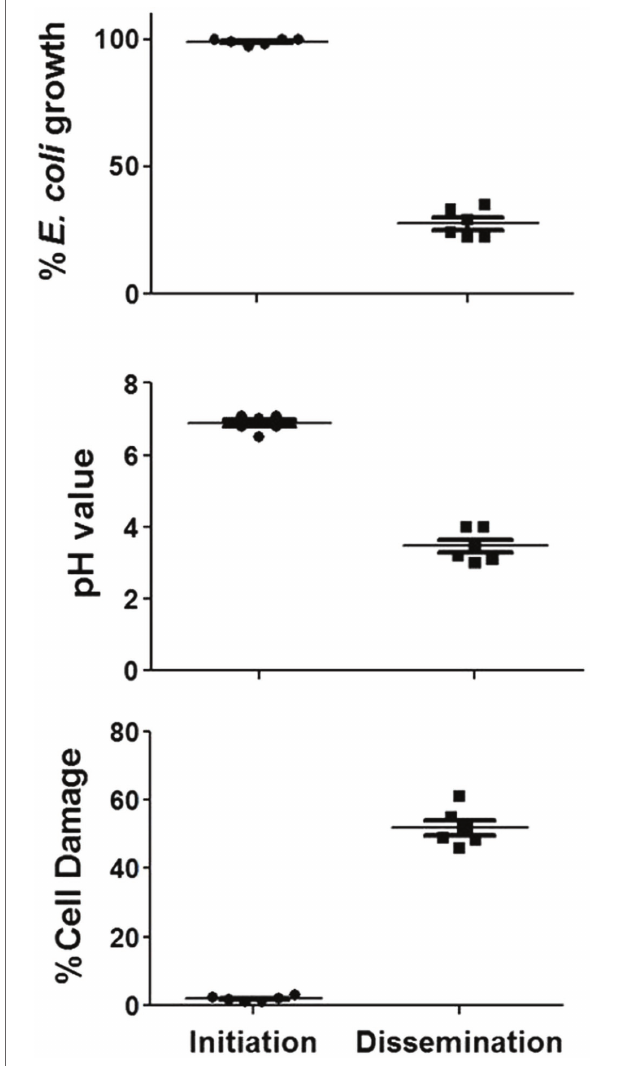
FIGURE 3 | Activity of R. arrhizus var. delemar cultures supernatants. Mammalian cell damage, pH values and anti- E. coli activities of concentrated Rhizopus PD (dissemination-like) versus F12K (initiation-like) cultures. All values are relative to control culture media without the